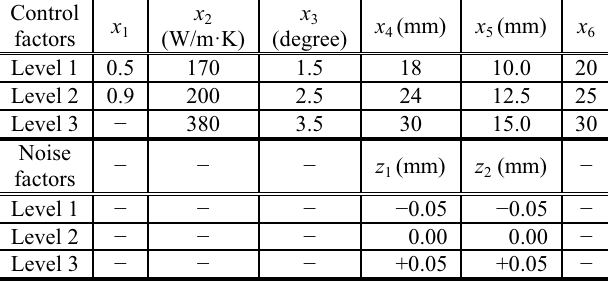
Table 2. Experimental settings of control and noise factors.